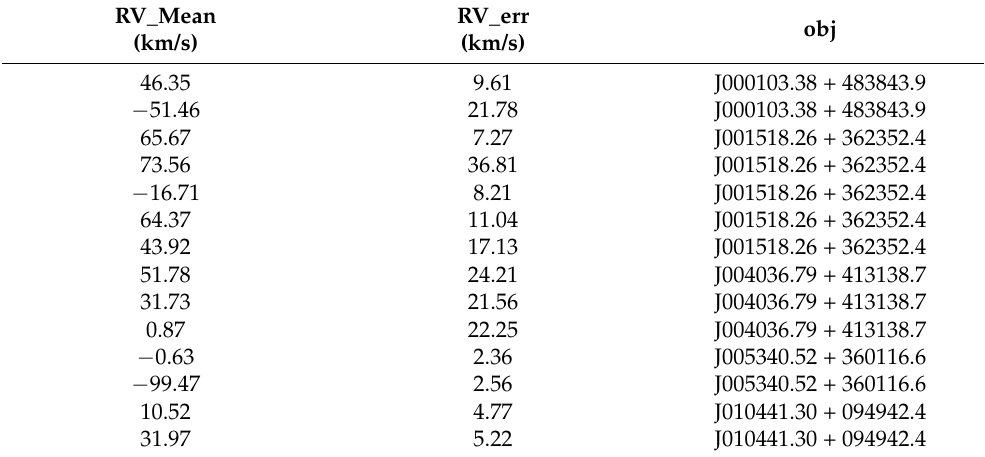
Table 1. Information on the top five objects.